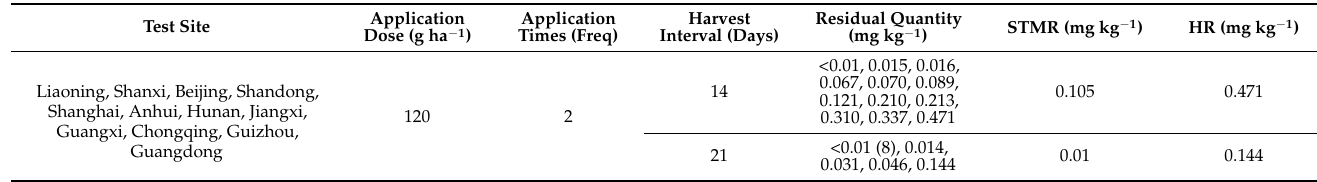
Table 3. Final residues of chlorfenapyr in cabbage.